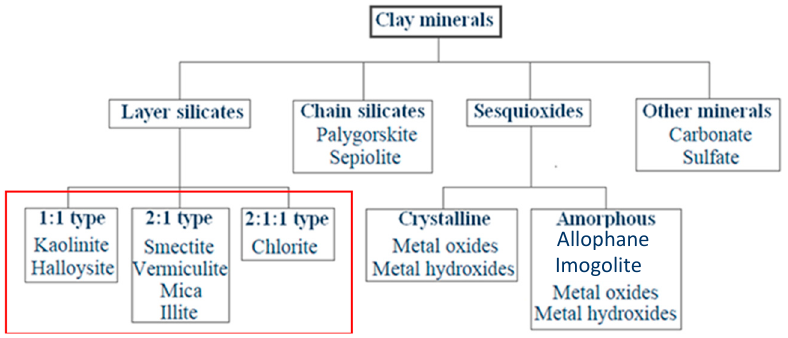
Figure 1. Classification of clay minerals [27–29].